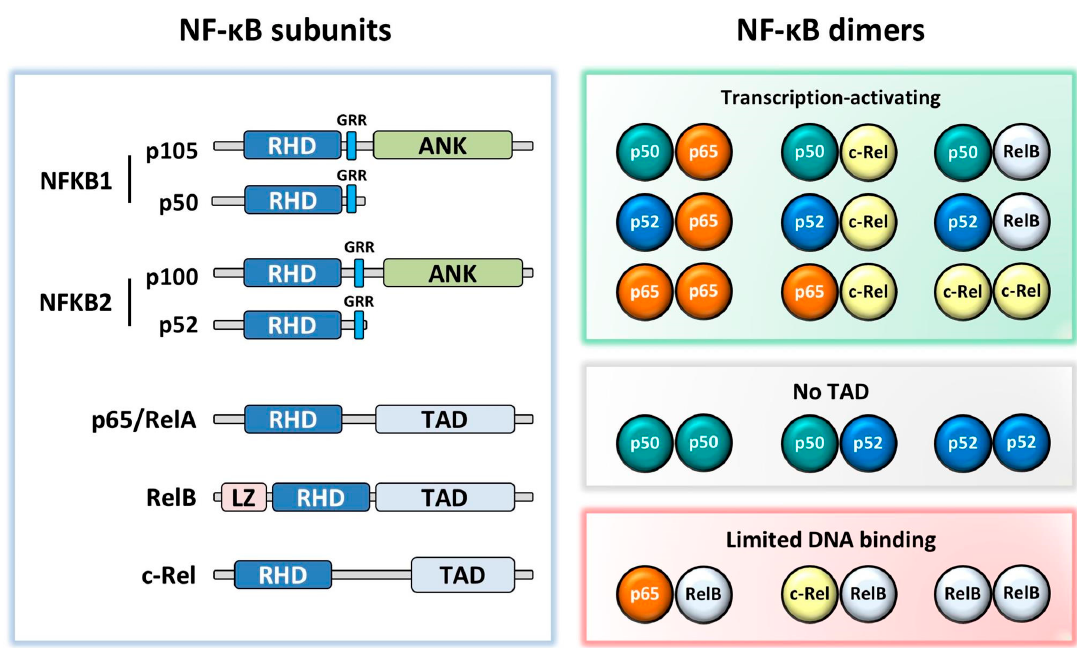
Figure 1. NF- κ B subunit structures and dimeric combinations. All subunits contain a Rel